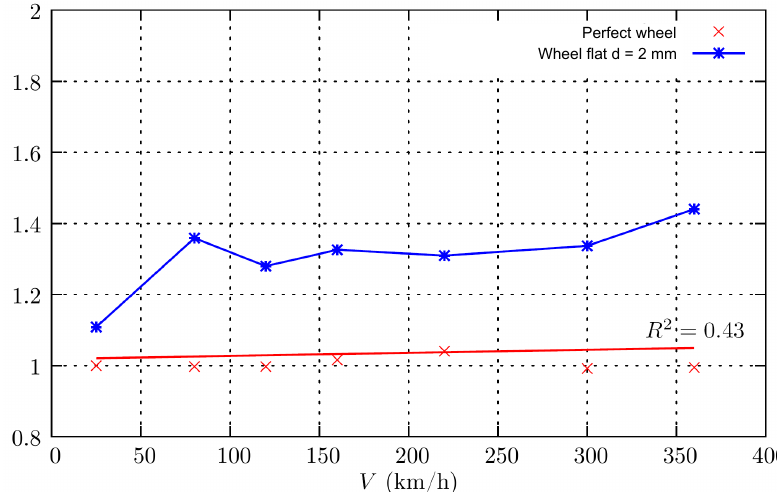
Figure 9. Dynamic amplification factor for the force on the fastening system: perfect wheel vs. flat wheel ( d = 2 mm), ballasted track.